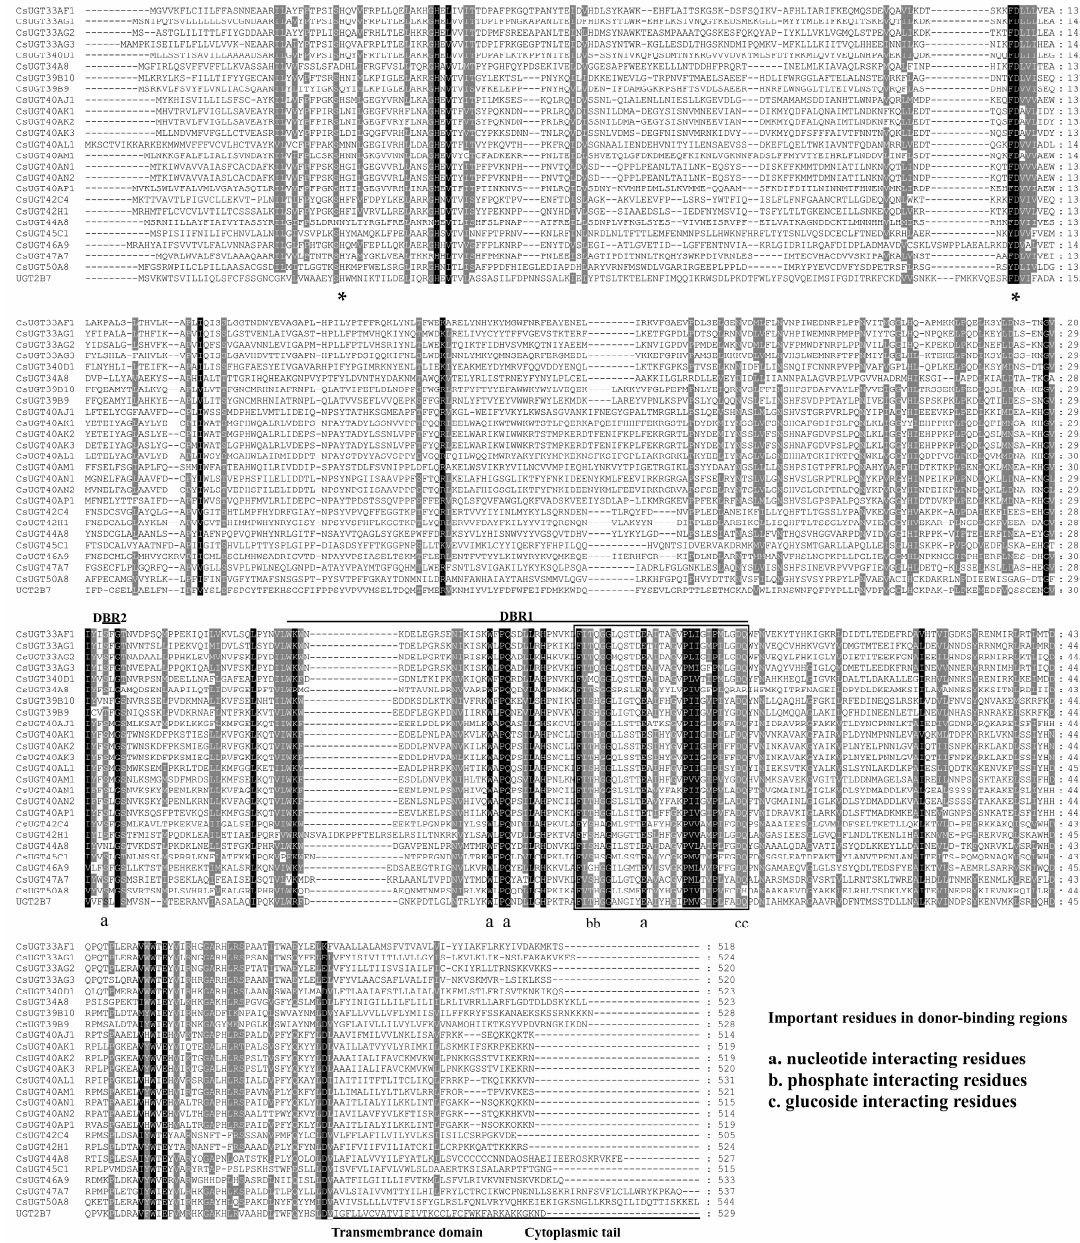
Figure 2. Multiple alignments of 24 UGTs in C. suppressalis with human UGT2B7 . The transmembrane domain and cytoplasmic tails based on human UGT2B7 are underlined. Asterisks ( * ) below alignments indicate the important catalytic residues (H and D). Black and grey background indicate that residues strictly conserved and residues well conserved, respectively. Two donor-binding regions (DBR1 and DBR2) are overlined. The signature motif is boxed. Several important residues interacting with the sugar donor are indicated by letters (a, b, and c) under the alignment.